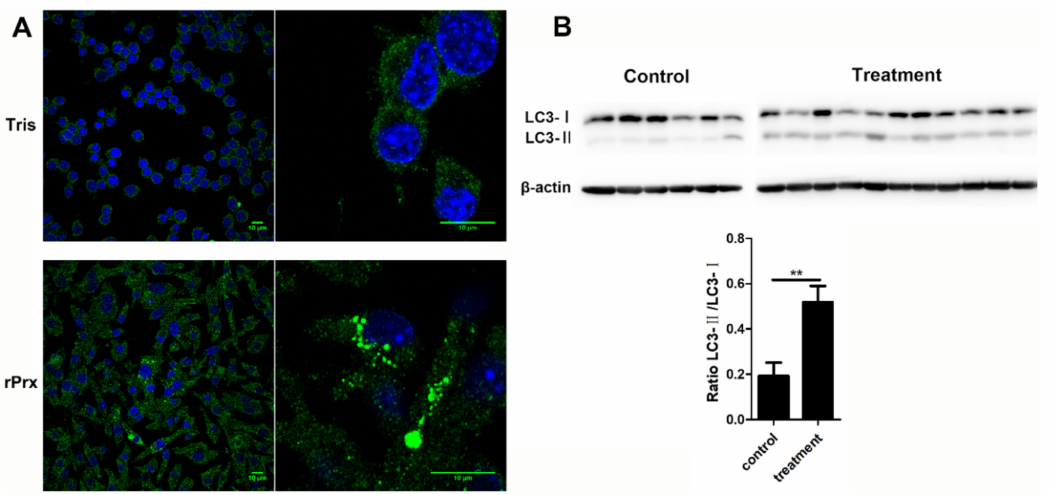
Figure 1. Autophagosome formation was induced by recombinant E. histolytica peroxiredoxin ( Eh -rPrx). ( A ) Eh -rPrx promoted light chain 3 (LC3) aggregation in macrophages. RAW264.7 cells were incubated with Eh -rPrx (5 µ g / mL) for 24 h and analyzed by immunofluorescence and confocal microscopy. Scale bar: 10 µ m. ( B ) Eh -rPrx could induce autophagy in vivo. Mice were intraperitoneally injected with Eh -rPrx (100 µ g) and peritoneal macrophages were analyzed after 12 h for LC3 expression by Western blotting. A representative image is shown. The data are expressed as the mean ± standard error of the mean (SEM) ( n = 6 or 11); ** p < 0.01 by Student’s t